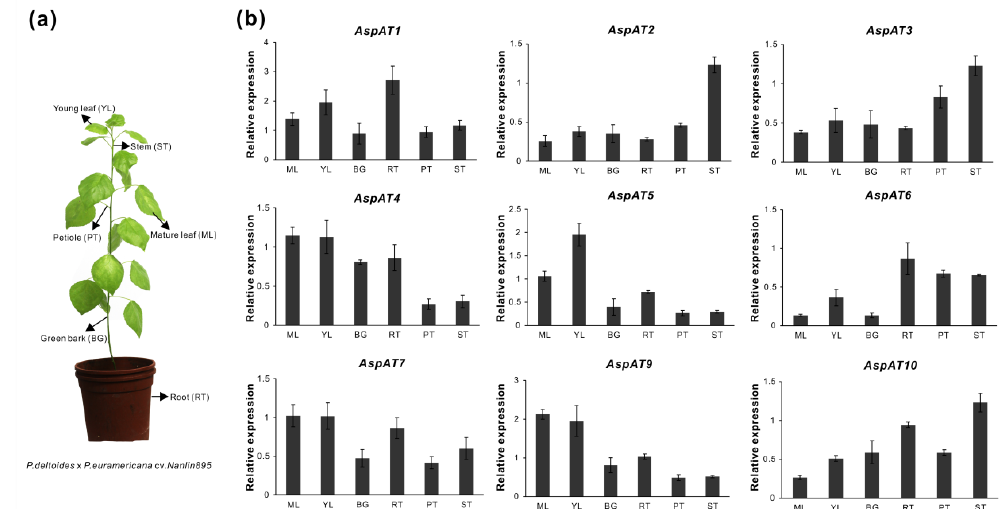
Figure 6. Expression analysis of AspAT genes in various tissues of poplar ‘ Nanlin895 ’. ( a ) Samples were harvested from ML (mature leaves), YL (young leaves), BG (green barks), RT (roots), PT (petioles), and ST (stems). ( b ) The expression analysis was conducted by qRT-PCR. Relative expression of ML was set as 1. Data represent mean values ± SE of at least three independent biological replicates for qRT-PCR. PtActin , PtUBIC , and PtEF1 α were used as reference genes.